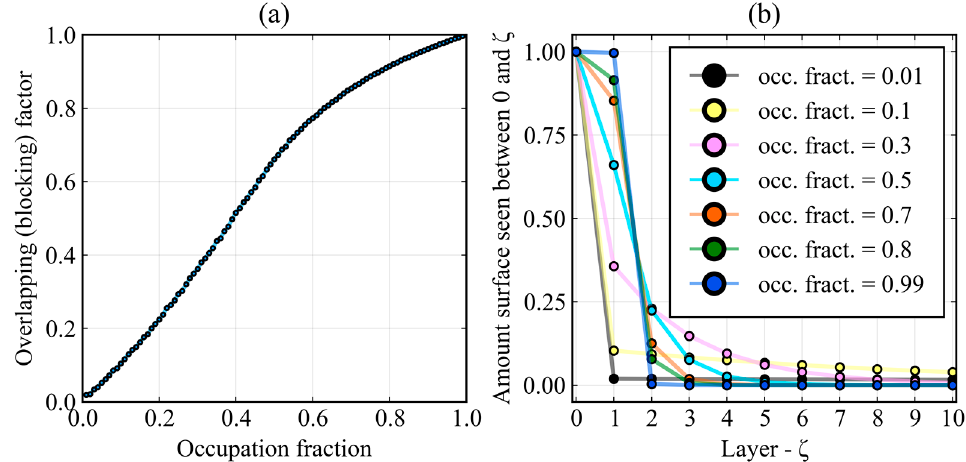
Figure 9. Calculated occupation fractions ( a ) and amount of “seen” surface between a cell 𝑖 and its neighboring cell 𝜁 ( b ).